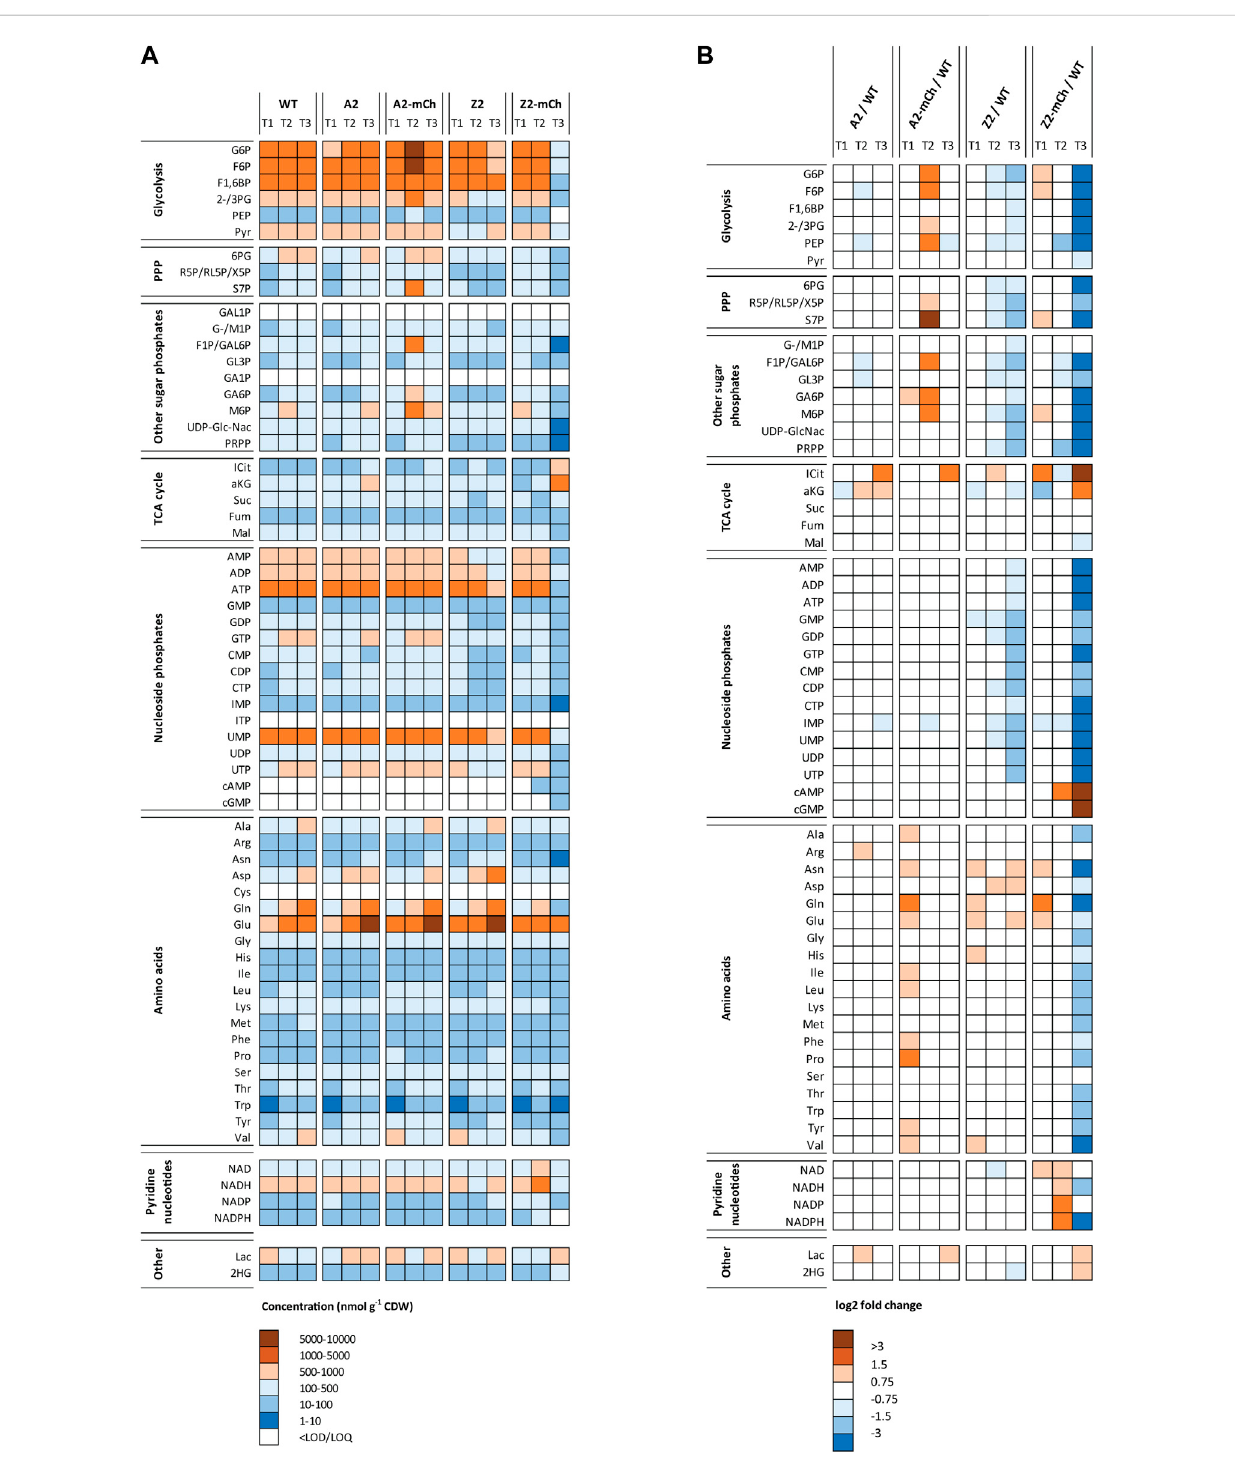
FIGURE 5 IntracellularmetabolitelevelsinstrainsWT Escherichiacoli BL21,A2,A2-mCh,Z2andZ2-mCh,duringatimeseriesbefore(T1)andafterinductionof RPP with m-toluate (A) Heatmap indicating the absolute intracellular metabolite concentrations (nmol g -1 CDW). Metabolite concentrations are color- coded according to their absolute concentrations, with red colorsindicating higher amounts and blue colors lower amounts. White color shows that the metabolite was below the LOQ or LOD for the given condition (B) Heatmap displaying the log 2 fold changes for each single metabolite, for all studied strains, with respect to the corresponding time point in the WT Escherichia coli BL21 strain. Red colors depict positive log 2 fold changes in the positive range (higher concentration that in the WT strain), while blue colors indicate log 2 fold changes in the negative range (lower concentration that in the WT strain). White indicates similar metabolite levels (from − 0.75 to 0.75 log 2 fold change). Metabolite abbreviations are listed in Supplementary Table S1. Numeric values for averages and RSD (%) for each condition and metabolite can be found in Supplementary Table